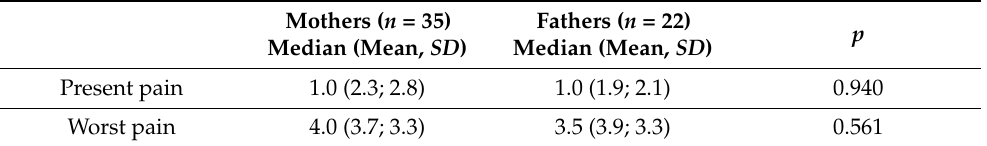
Table 5. Present and worst pain on VAS (range 0–10) for mothers and fathers of children with TS.